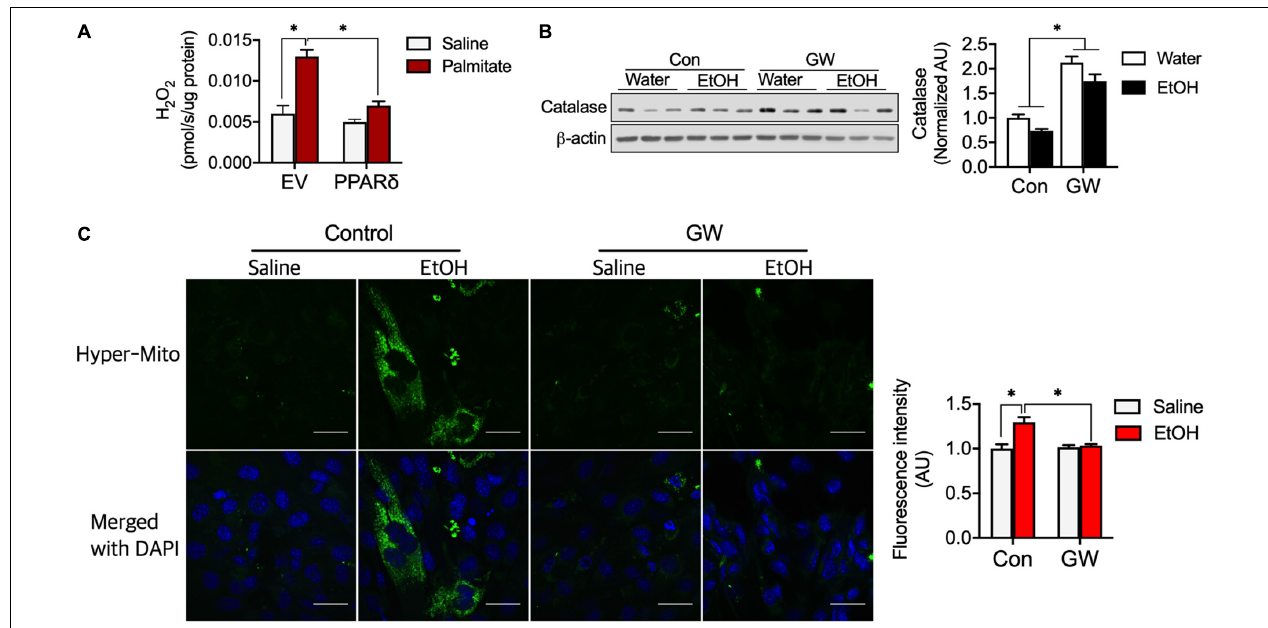
FIGURE 5 | PPAR δ attenuated fatty acid-induced ROS by increasing catalase protein content. (A) PPAR δ attenuated palmitate increased H 2 O 2 levels in myotubes ( n = 6 myotubes/group). (B) PPAR δ activation increased catalase protein content in mouse skeletal muscles ( n = 6–7 muscles/group). (C) Representative image of H 2 O 2 emission from mitochondria obtained using an H 2 O 2 sensor (HyPer-mito, green, Moscow). Nuclei were stained with DAPI. Scale bar, 30 µ m. Values are means ± SE. Significance was determined by two-way ANOVA with Tukey’s correction, * P <